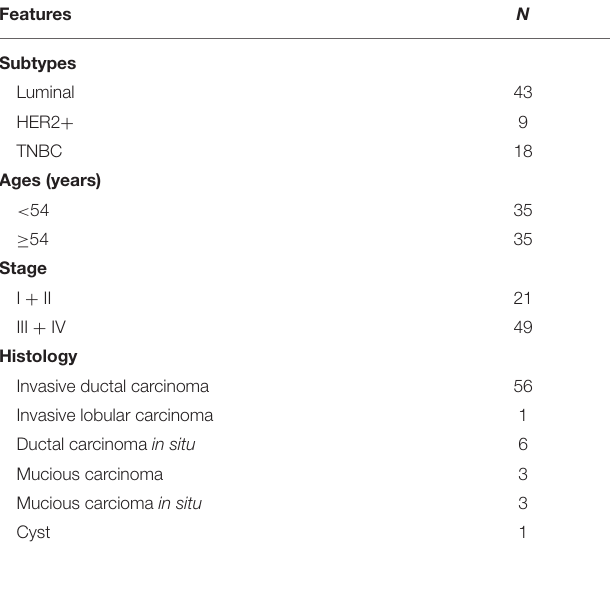
TABLE 1 | Phenotypic information of 70 collected samples.